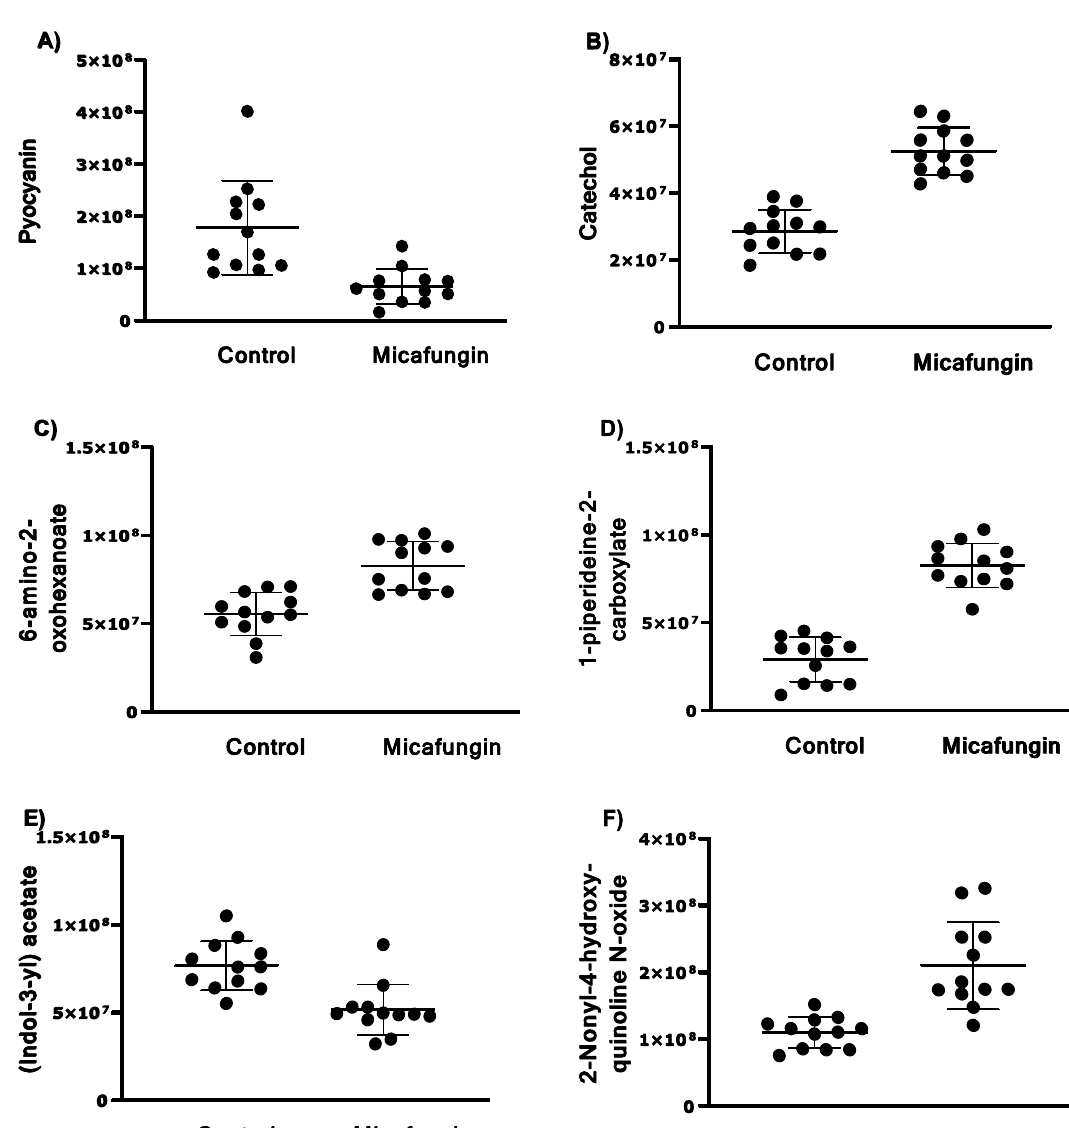
Fig. 5 Significantly altered extracellular metabolites (both in univariate and multivariate analysis) in P. aeruginosa biofilm effluent treated with micafungin. Data are presented as the peak area for each metabolite as determined by LC–MS/MS analysis in the 12 replicates in control and micafungin